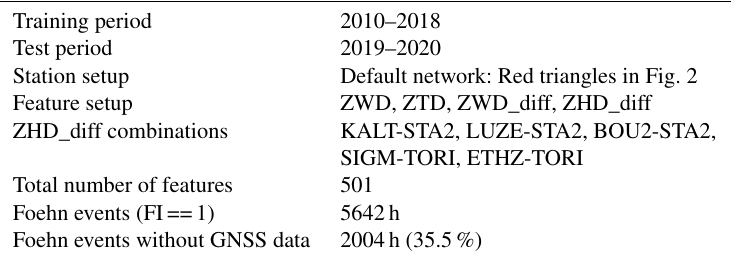
Figure 3. Time series of observed (red, FI) and predicted (orange = GB, blue = SVC) foehn events (FI == 1) for all FS experiments and their respective time periods (2019–2020 or 2019). Note that all observed foehn events are shown here, including those for which no prediction could be made due to missing GNSS data. Table 6. Default setup used for FS2. For features not outlined in a specific row, by default, all stations and combinations of stations are